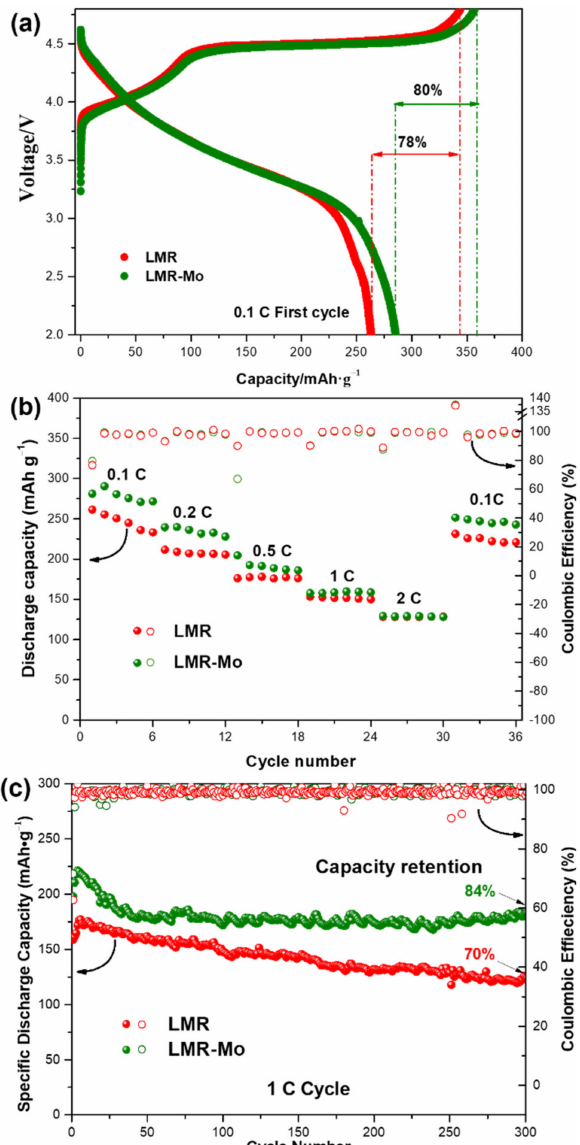
Figure 4. Electrochemical performance of LMR and LMR-Mo: ( a ) initial charge/discharge profiles at a rate of 0.1 C; ( b ) rate performance; ( c ) cycling stability performance at a rate of 1